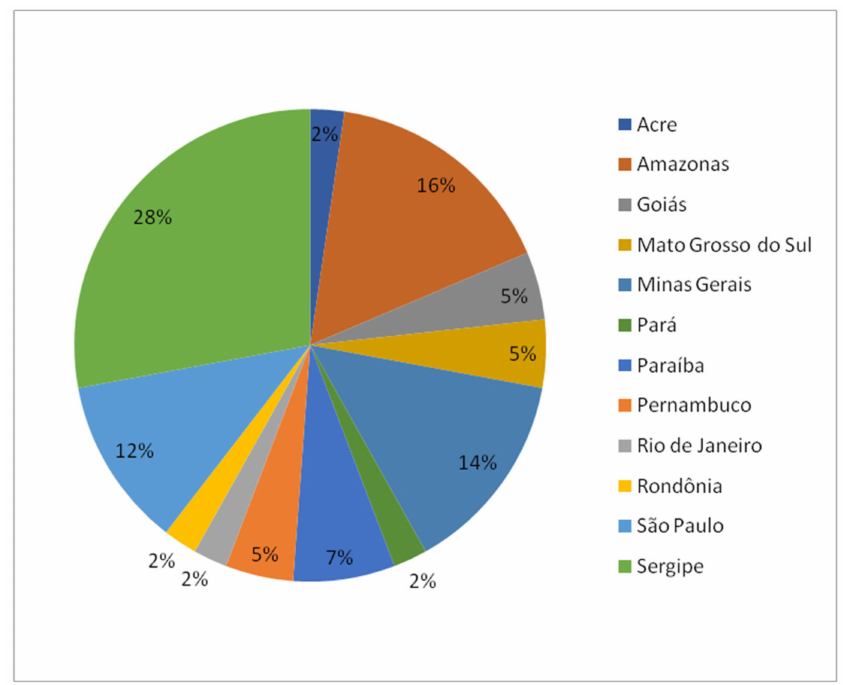
Figure 2. Percentage of studies conducted with essential oils from Annonaceae species collected in Brazil between the years 2011 and